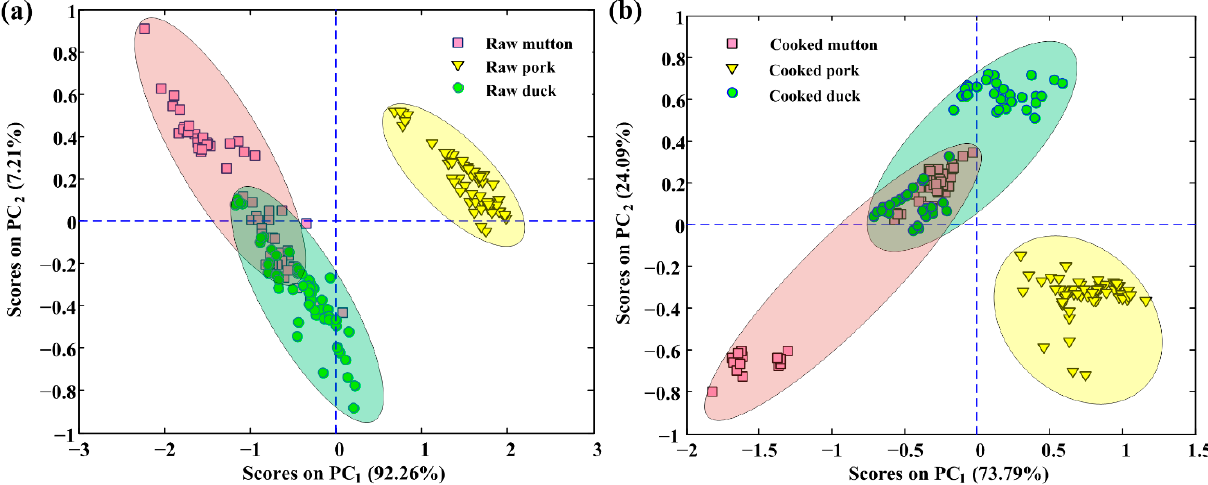
Figure 3. Score plots for the first two PCs (PC 1 vs. PC 2 ) using spectra collected from ( a ) raw and ( b ) cooked meat rolls.